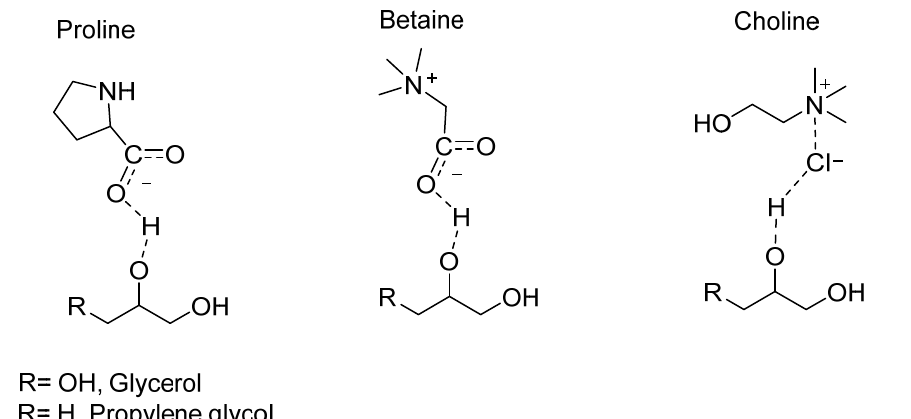
Figure 2. NaDES prepared and evaluated in this work. From the left: proline-, betaine- and choline- based NaDES as hydrogen bond acceptor and glycerol (R=OH) or propylene glycol (R=H) as hydrogen bond donors.